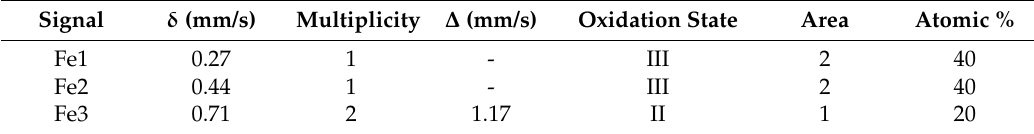
Figure 8. Experimental 57 Fe Mössbauer spectrum and curve fits for each iron-containing species in 1. Table 4. Experimental results obtained from the 57 Fe Mössbauer spectrum of 1 .